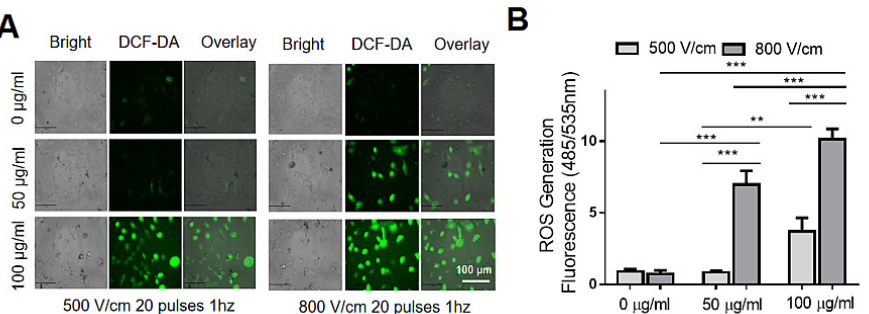
Figure 3. Increased cellular ROS levels under the combination treatment of EMT-6 cells with IRE and Au-MSNs. Cellular ROS was measured using a DCF-DA dye after IRE treatment (500 V/cm or 800 V/cm, 20 plus, 1 Hz) with different amounts of Au-MSNs. ( A ) Fluorescence microscopic images of EMT-6 cells after DCF-DA staining. DCF-DA staining proved cellular ROS was increased by IRE treatment with Au-MSNs. ( B ) Quantification of green fluorescence intensity of EMT-6 cancer cells. Data are provided as means ± standard deviation. Data were tested for significance using two-way ANOVA. Significant differences are indicated by ** p < 0.05, *** p < 0.01 (n= 3–5).